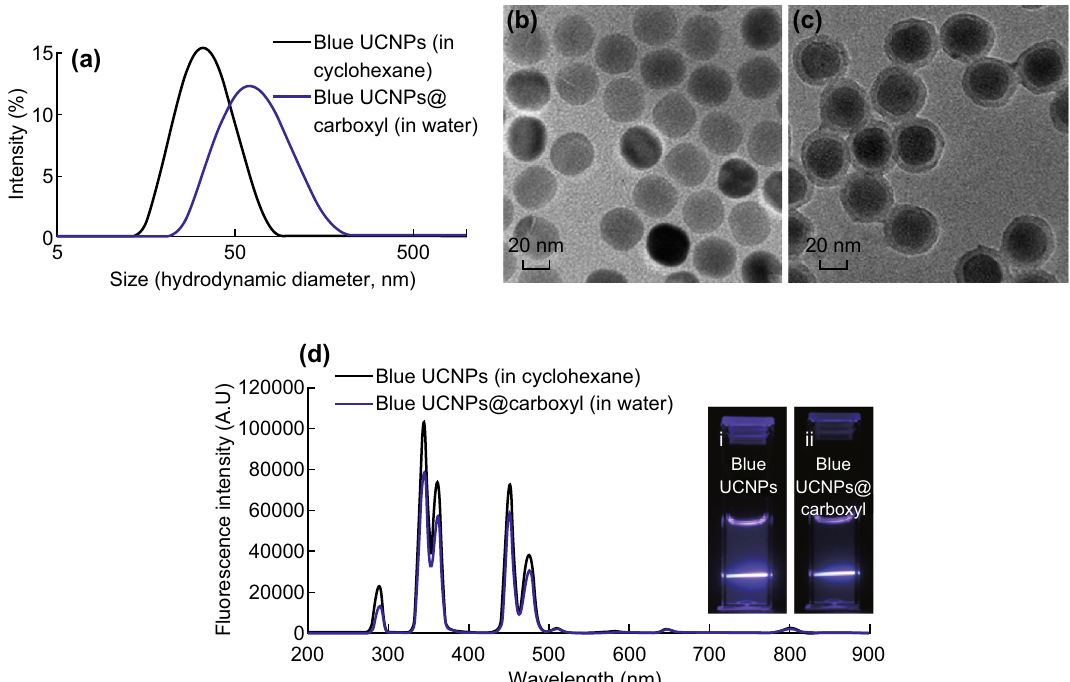
Fig. 5 a Size distribution of NaYF 4 :30%Yb0.5%Tm UCNPs with and without carboxyl modification in cyclohexane and in water, respectively. TEM images of b NaYF 4 :30%Yb0.5%Tm UCNPs in cyclohexane, and c NaYF 4 :30%Yb0.5%Tm@carboxyl UCNPs in water. d Emission fluorescence spectra of NaYF 4 :30%Yb0.5%Tm UCNPs with and without surface modification in cyclohexane and in water, respectively, and insets are corresponding camera picture of (i) NaYF 4 :30%Yb0.5%Tm, and (ii) NaYF 4 :30%Yb0.5%Tm@carboxyl